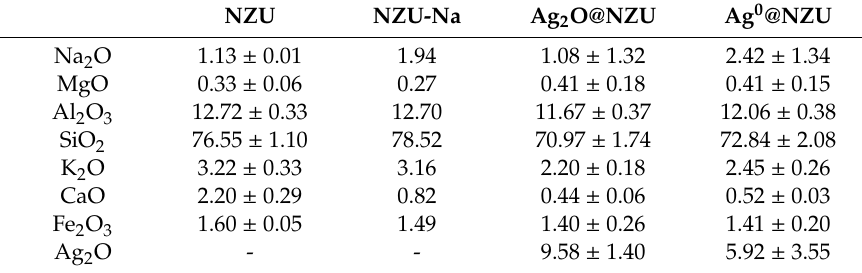
Table 3. XRF analysis results of zeolite samples (% w / w